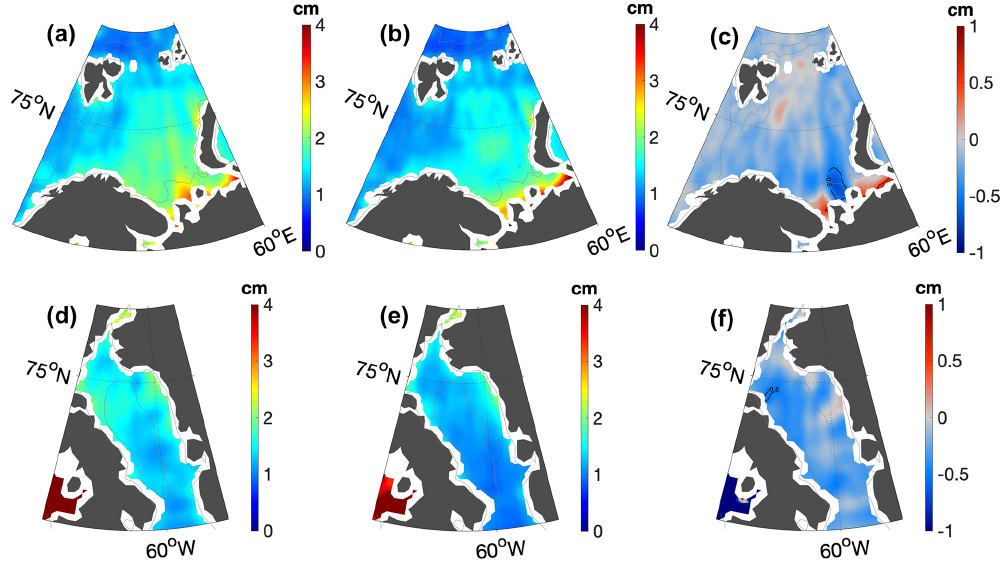
Figure A1. Comparison of performances of FES2004- and FES2014-based corrections. Sub-monthly contribution to the standard error on monthly η (cid:48) maps in the Barents Sea (a–c) and Baffin Bay (d–f) when using the tidal corrections FES2004 (a, d) and FES2014 (b, e) . In panels (c) and (f) is shown the reduction in the error obtained with FES2014 with respect to FES2004.